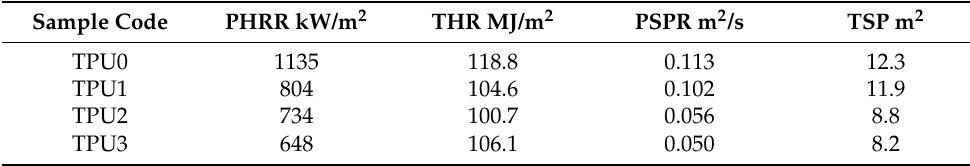
Figure 6. Heat release rate curves of TPU composites. Table 2. Cone calorimeter data of TPU